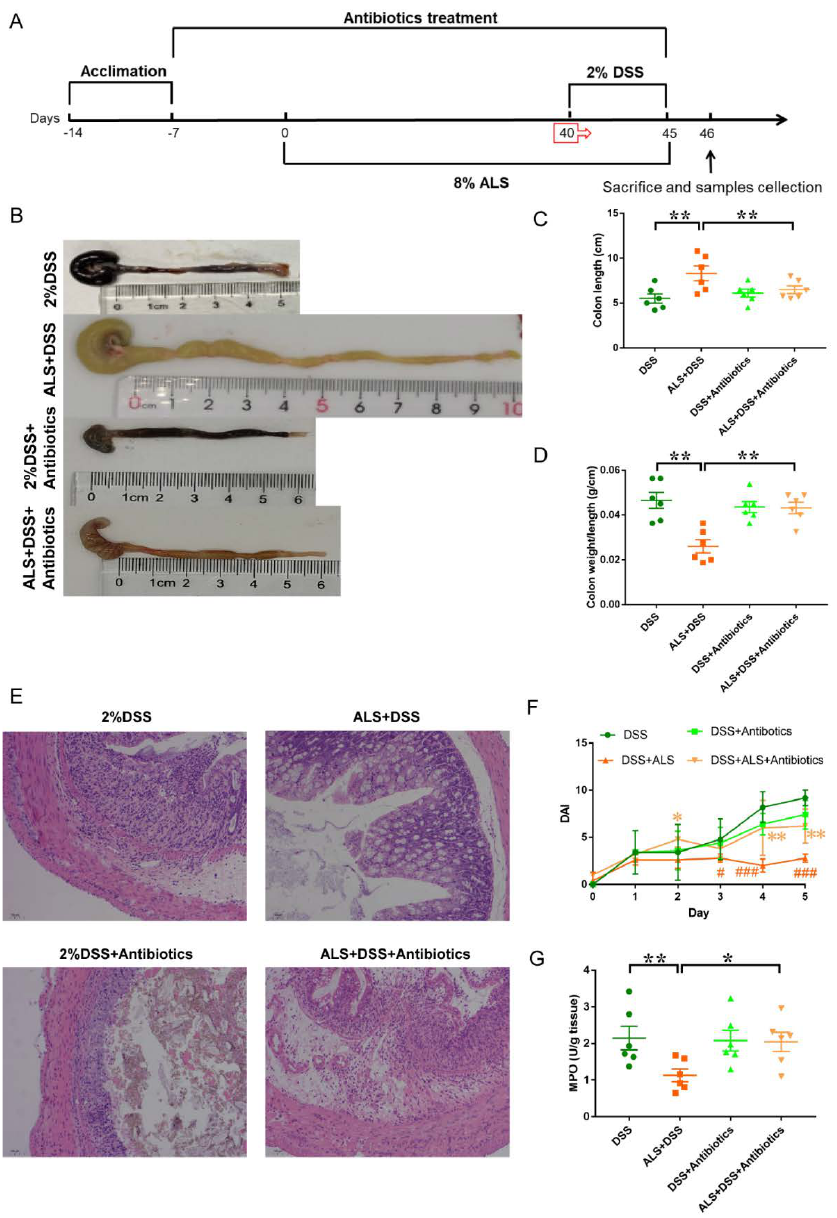
Figure 7. Antibiotics treatment attenuated the protective effects of ALS on DSS-induced colitis. ( A ) Study design of the experiment. ( B ) Pictures of colon samples showing the colon length. ( C ) Colon length. ( D ) Colon weight/length ratio. ( E ) Representative colon histological sections of mice treated with antibiotic or not. ( F ) Disease activity scores. # p < 0.05, ### p < 0.001, relative to DSS group; * p < 0.05, ** p < 0.01, relative to DSS+ALS group. ( G ) MPO activity of the colitis mice with antibiotics pretreatment or not. Data are mean ± SEM. n = 5–6 mice per group. * p < 0.05, and ** p <